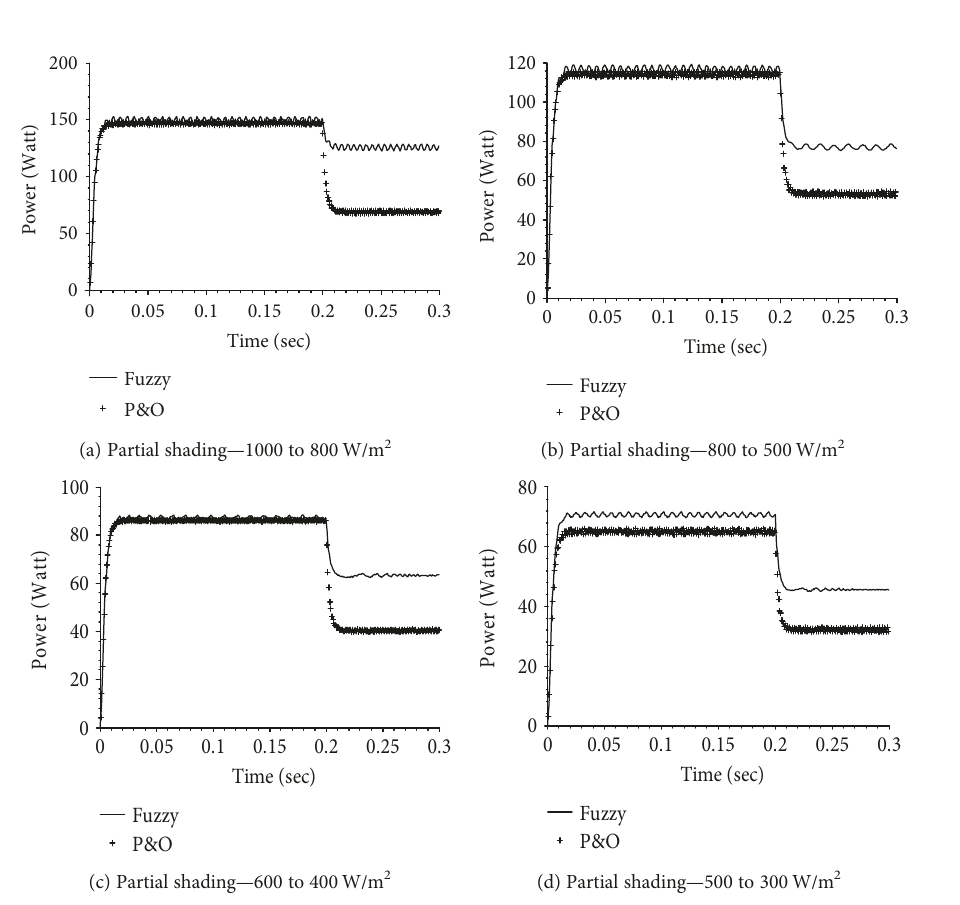
Figure 7: Comparison between fuzzy and P&O partial